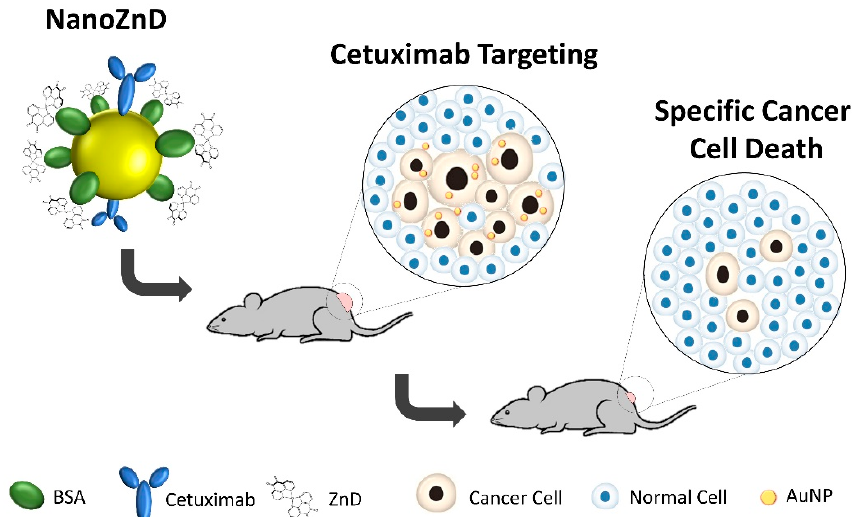
Figure 1. Schematic representation of the NanoZnD strategy. The gold nanoparticle (AuNP) core is covered by polyethylene glycol (PEG) for improved biocompatibility and stability in complex media; the antiproliferative compound—ZnD ([Zn(DION) 2 ]Cl 2 )—is embedded within bovine serum albumin (BSA) and cetuximab for targeting.